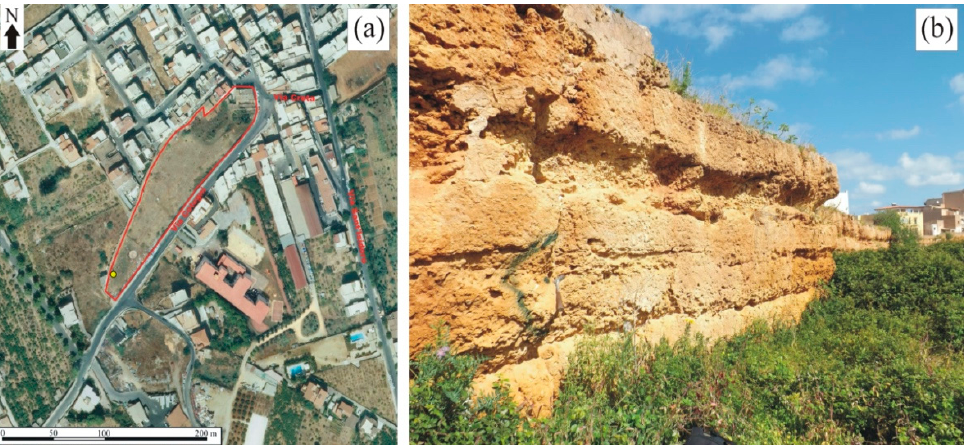
Figure 1 . ( a ) Aerial photo with quarry location (in red the perimeter of the quarry) and sampling point (yellow circle); ( b ) “Guttadauro” quarry front.